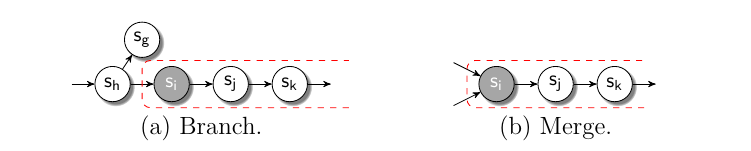
Figure 3: Input independent state series starting point s i (series marked in dashed red):